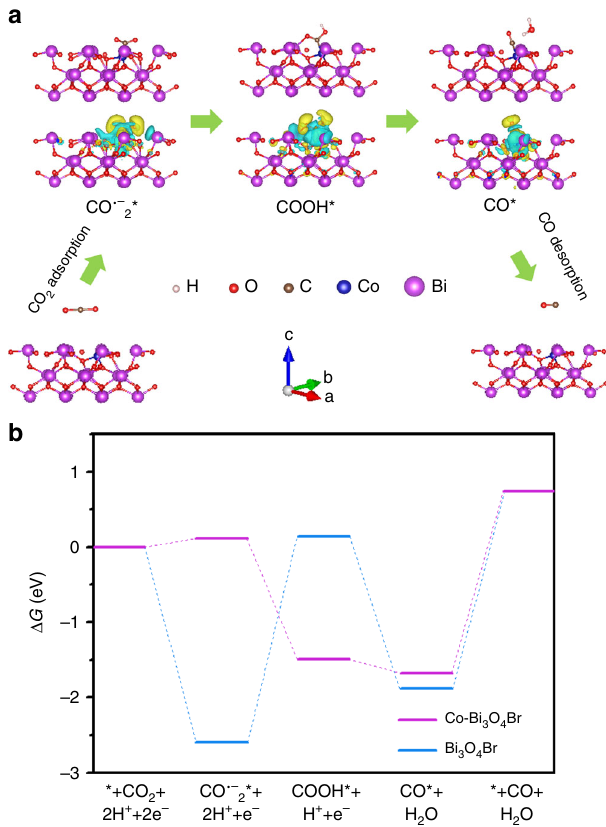
Fig. 4 Theoretical study. a Schematic representation of CO 2 photoreduction mechanism on the Co – Bi 3 O 4 Br, b free energy diagrams of CO 2 photoreduction to CO for the Bi 3 O 4 Br and Co – Bi 3 O 4